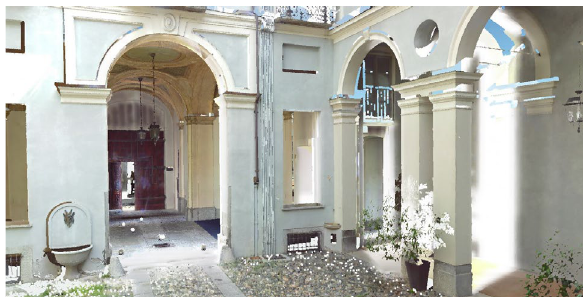
Figure 6 . Location of referential spheres in the main reception space. Image extracted from the point cloud (processing by C. López González).